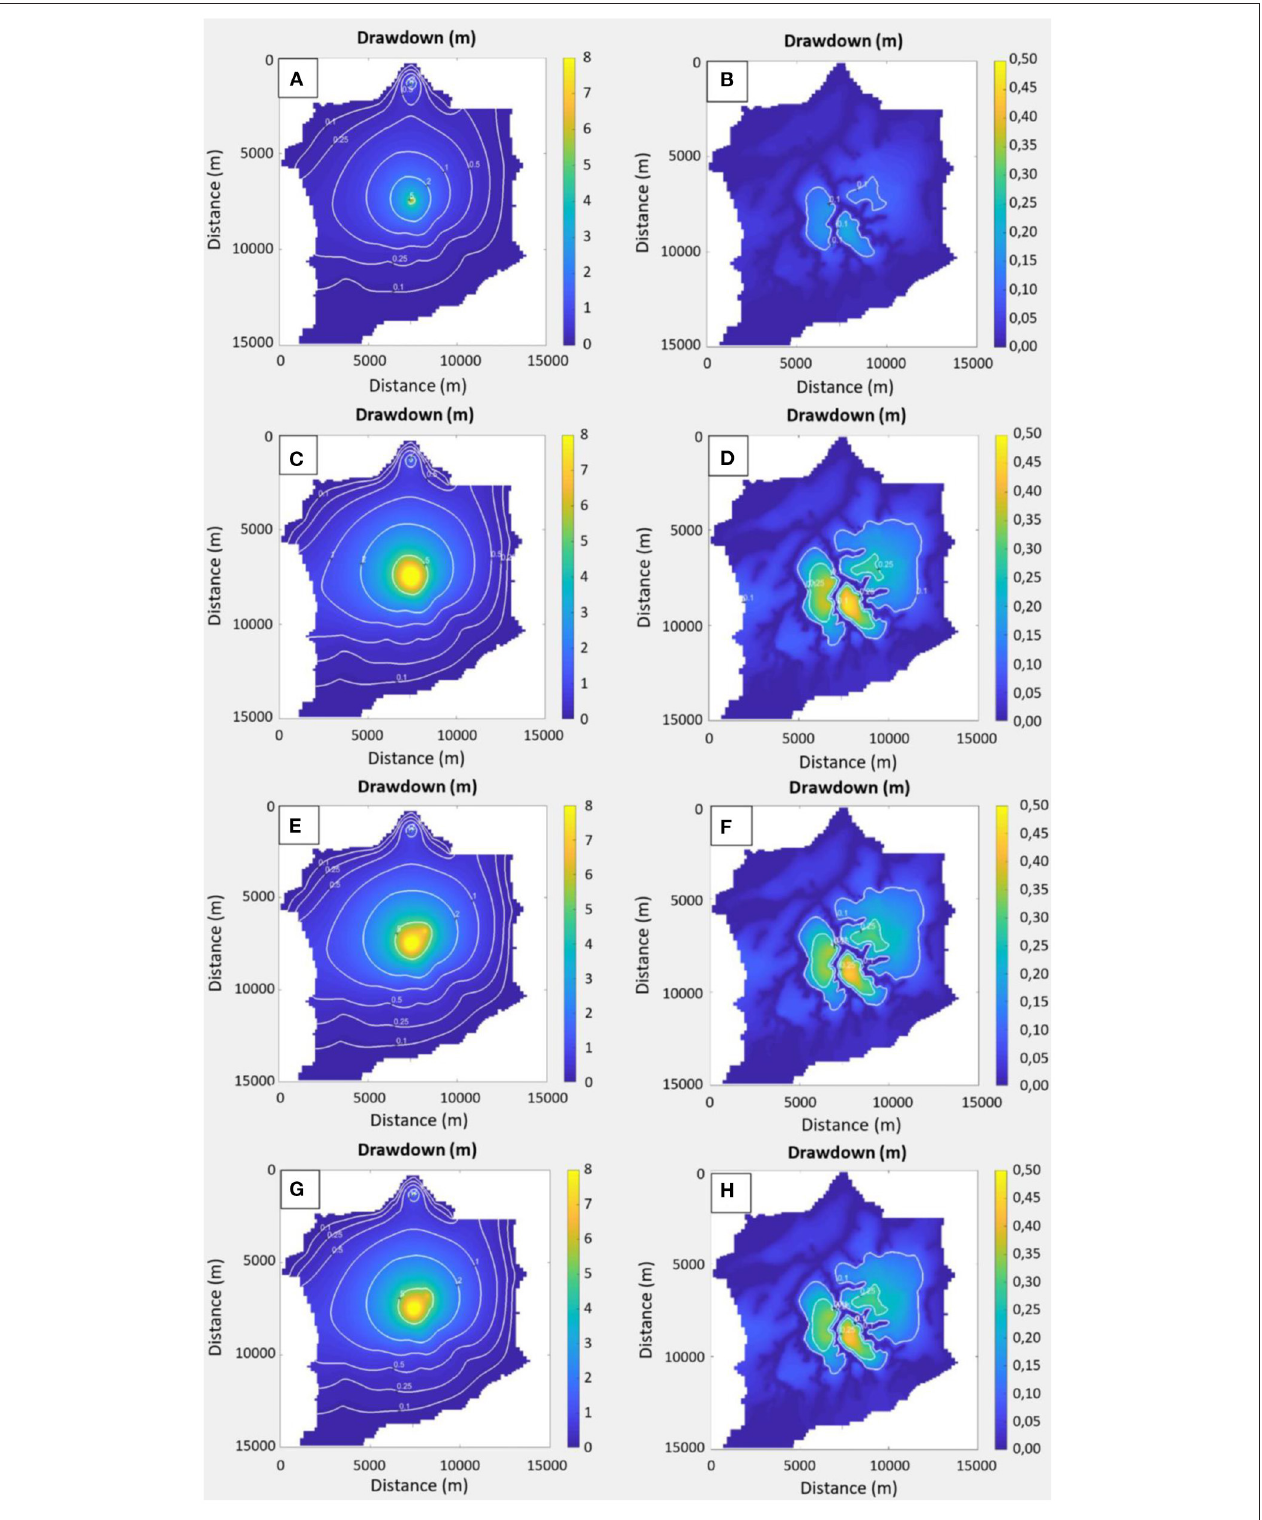
FIGURE 10 | (A) Drawdown in the formation of Maastricht (layer 8) in scenario 1 ( Table 4 ). (B) Drawdown in the Quaternary (layer 1) in scenario 1. (C) Drawdown in the formation of Maastricht in scenario 2. (D) Drawdown in the Quaternary in scenario 2. (E) Drawdown in the formation of Maastricht in scenario 3. (F) Drawdown in the quaternary in scenario 3. (G) Drawdown in the formation of Maastricht in scenario 4d. (H) Drawdown in the quaternary in scenario 4d.